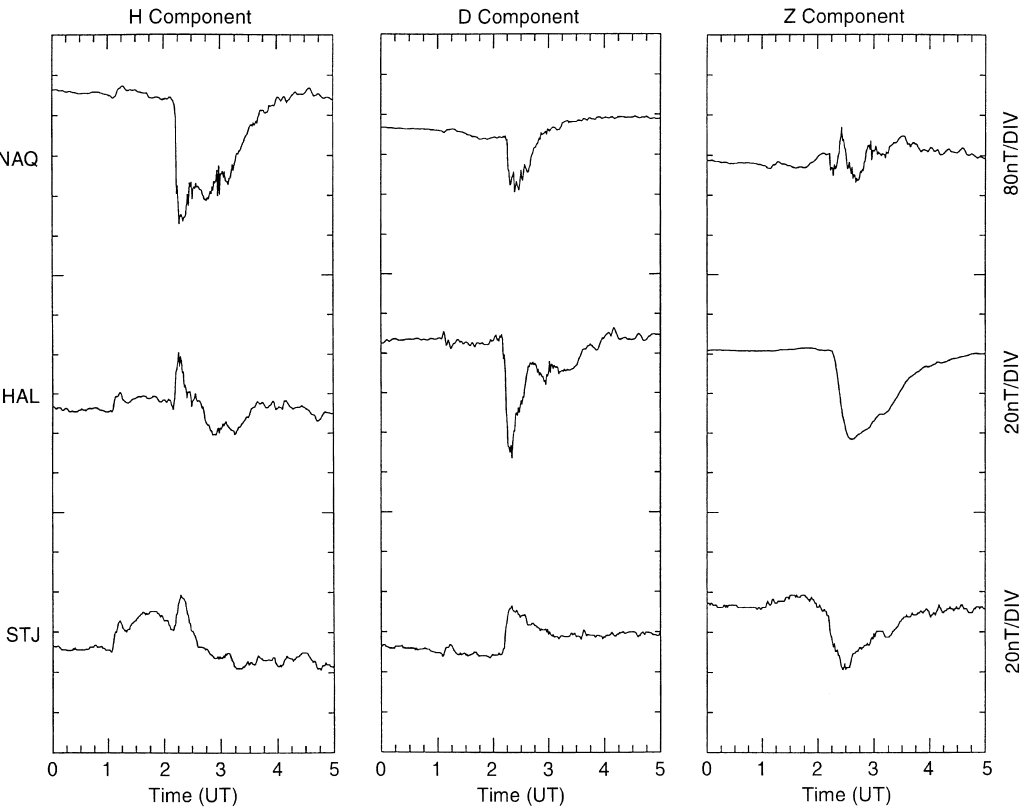
time magnetic field is in the H-Z plane. Positive H points to local magnetic north, positive D to local magnetic east, and positive Z to nadir for NAQ and STJ and zenith for HAL